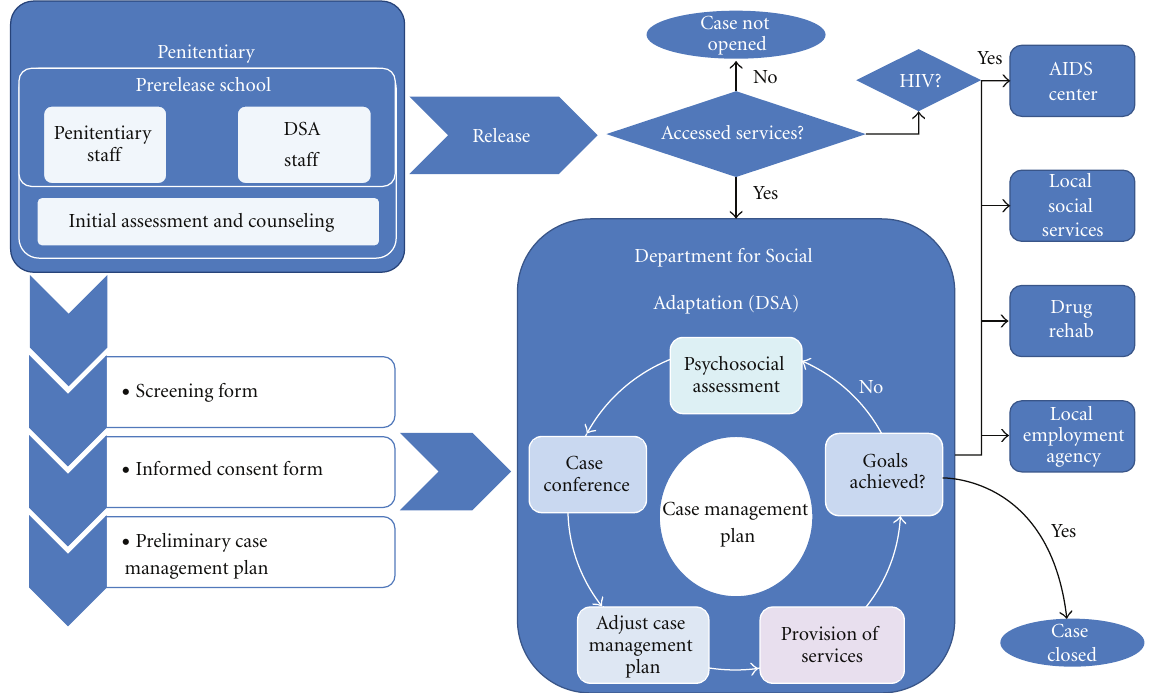
Figure 3: Psychosocial adaptation of recent female prisoners.